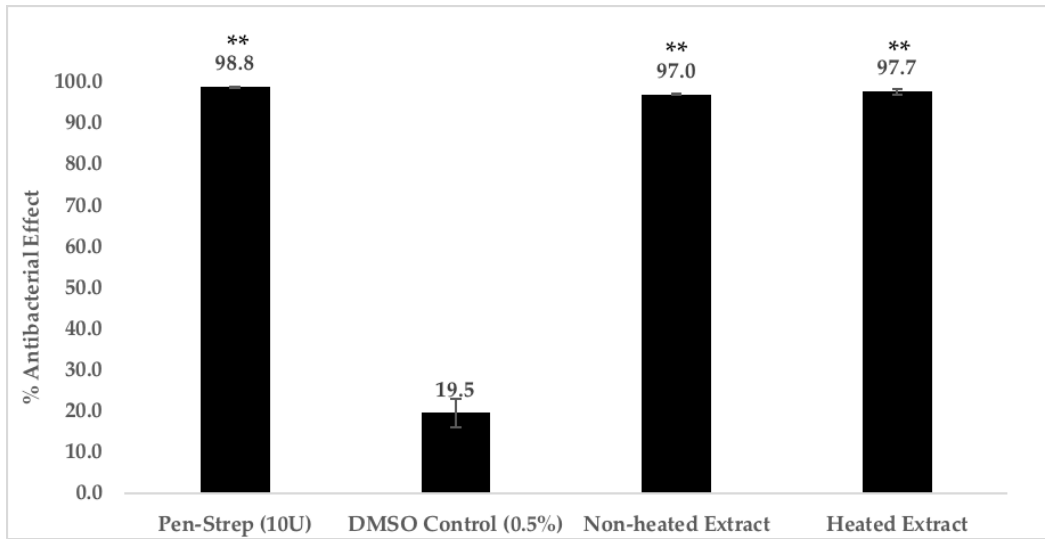
Figure 2. Heat treatment of C. racemosa chloroform extract. C. racemosa chloroform extract at 250 μg/mL was heated at 95 °C for 30 min prior to use for antibacterial studies. 1 × 10 6 bacterial cells were then incubated with the heated and non-heated C. racemosa chloroform extract, respectively, for 2 h at 37 °C. Next, the samples were serially diluted (10-fold) and plated on Nutrient Agar followed by 18 h of incubation at 37 °C. Finally, bacterial colonies were enumerated and recorded to obtain the % of reduction of bacterial cells. Results represent three independent experiments performed in triplicates. * indicates p < 0.05, ** indicates p < 0.01, *** indicates p < 0.001.